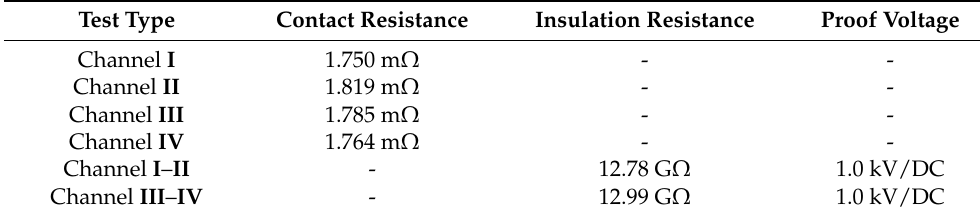
Table 3. Electrical test results of the prototype in a dry environment *.